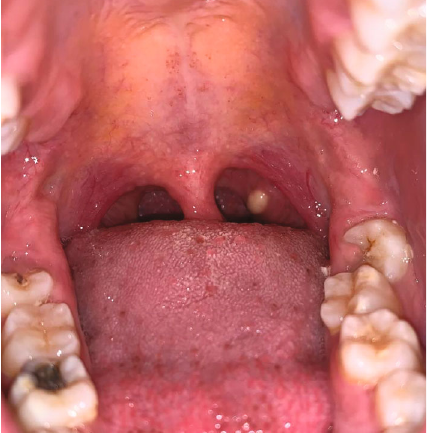
Figure 1: Clinical presentation of a 0.5 cm, yellow nodule with intact mucosa arising from the left palatine